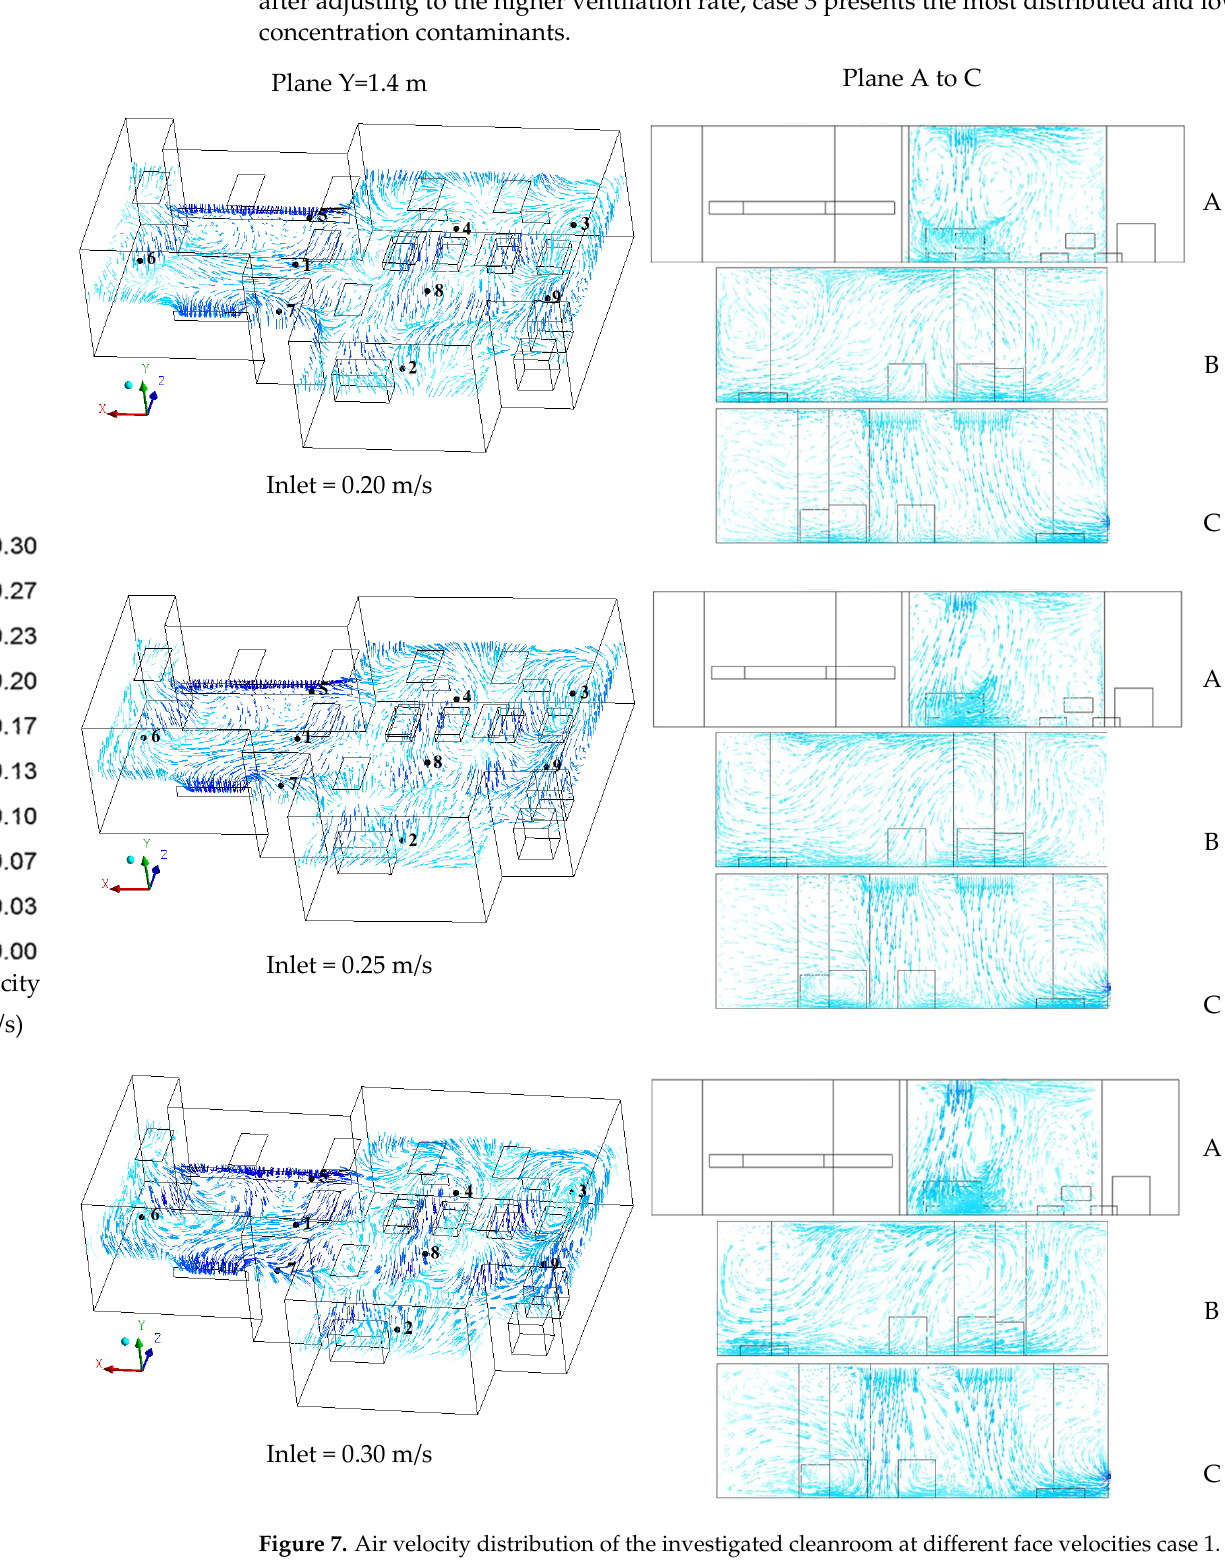
Figure 7. Air velocity distribution of the investigated cleanroom at different face velocities case 1.